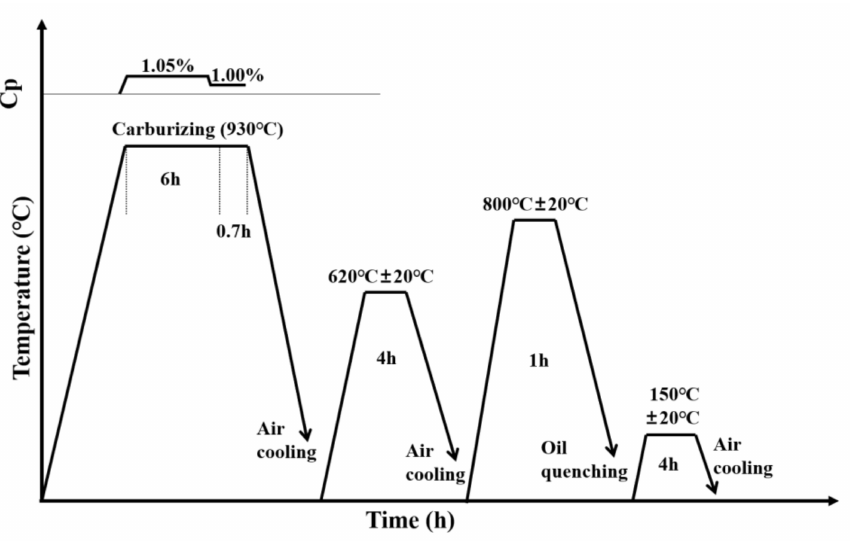
Figure 3. Preparation process of the C-Nary rings.